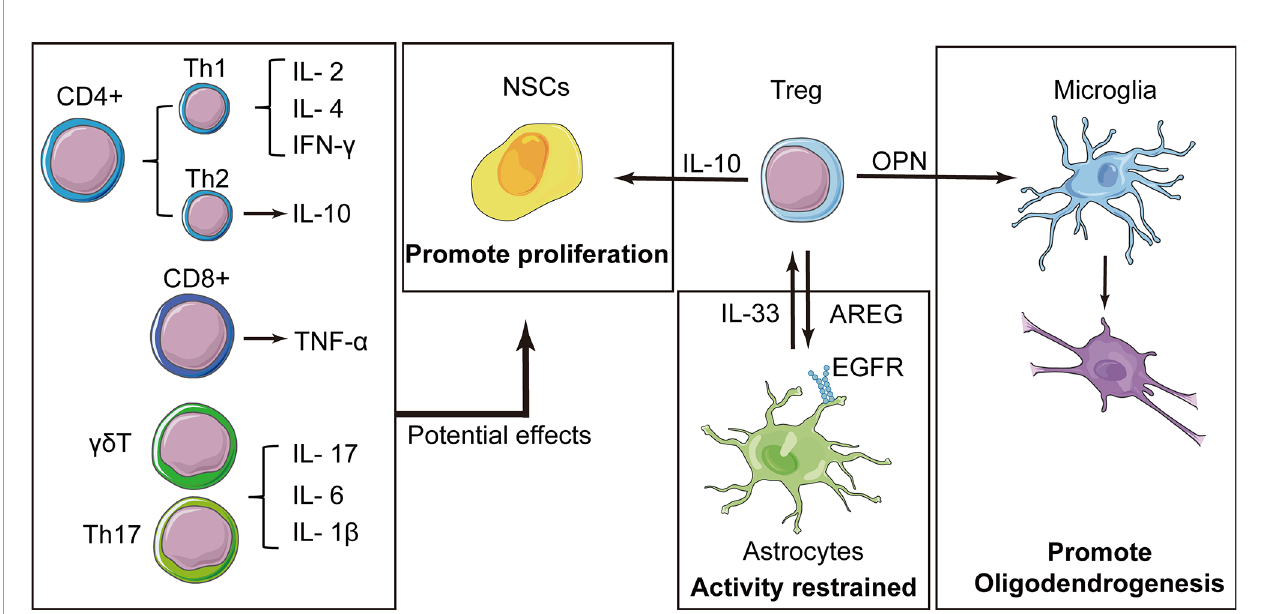
FIGURE 4 | Tregs play a central role in the immune cell-mediated nerve repair process. In addition to the resolution of in fl ammation, Tregs express interleukin (IL)-10 that contributes to the proliferation of neural stem cells (NSCs). Tregs also produce amphiregulin (AREG), which are bound to epidermal growth factor receptors on astrocytes and inhibit deleterious astrocytic reaction. Osteopontin (OPN) is also secreted by Tregs and induces the reparative phenotype of microglia, promoting oligodendrogenesis. Some cytokines have been reported to have effects on NSCs, and these factors have also been expressed in other types of T cells, suggesting that these T cells may also have potential effects on